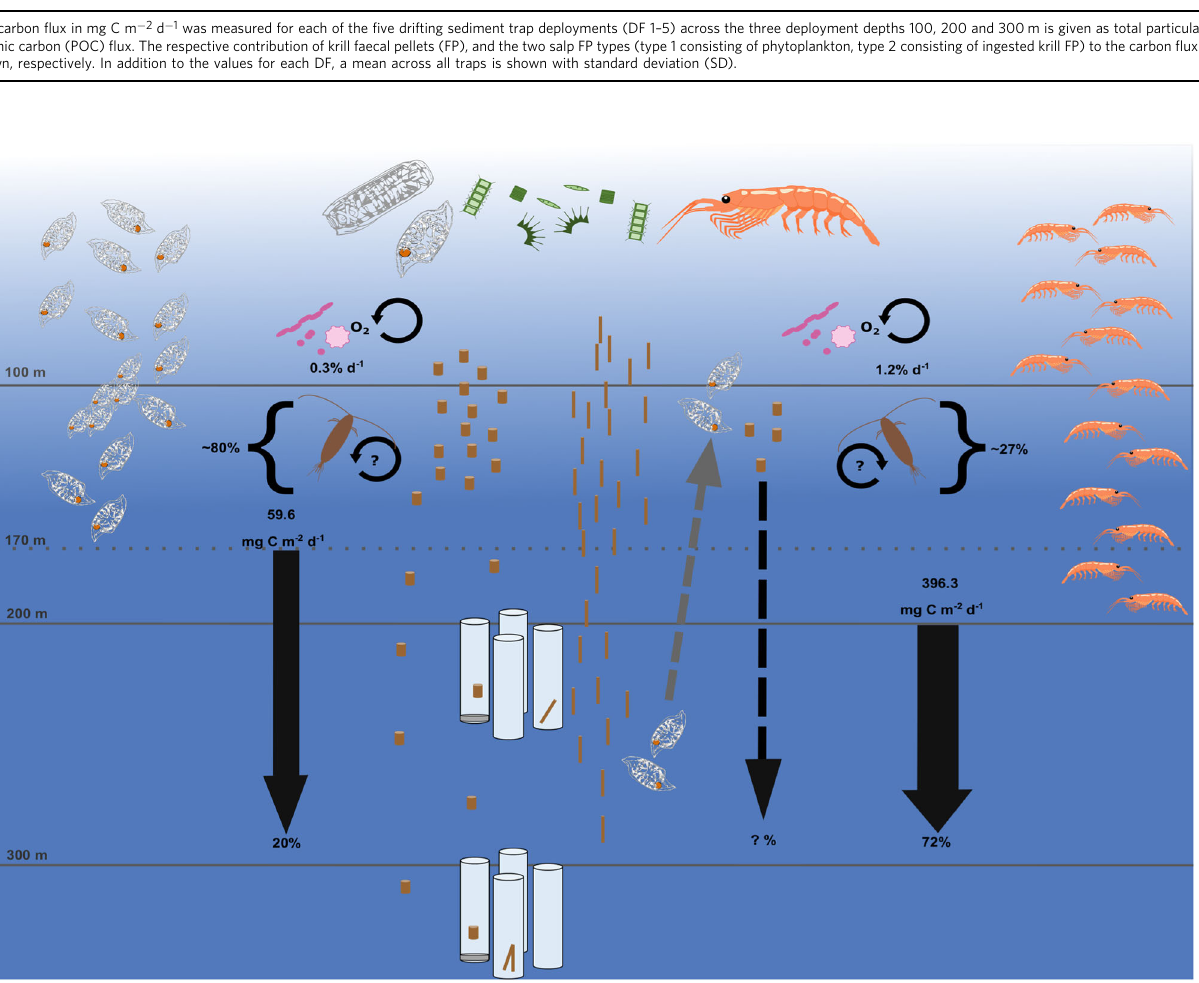
Fig. 2 Potential faecal pellet (FP) fl ux and export ef fi ciency of krill and salp FP. The potential fl ux of FP of krill in the upper 200 m accounted on average for 396.3 mg C m − 2 d − 1 , incl. the presence of dense krill swarms, resulting in an export ef fi ciency of krill FP of 72% to 300 m. The fl ux of salp FP in the upper 170 m accounted for 59.6 mg C m − 2 d − 1 for FP produced from feeding on phytoplankton (type 1), resulting in an export ef fi ciency of 20% to 300 m. The carbon-speci fi c microbial respiration accounted for only 0.3% of the carbon loss per day for salp FP, and for 1.2% d − 1 for krill FP. Consequently, other remineralisation processes and zooplankton-mediated processes, such as feeding and loosening of the pellets must account for the retention of about 80% of salp FP, and 27% of krill FP in the top 200 m. The dashed arrow depicts the production of type 2 FP at the surface after feeding on krill FP at depth and the unknown contribution to the export fl ux of